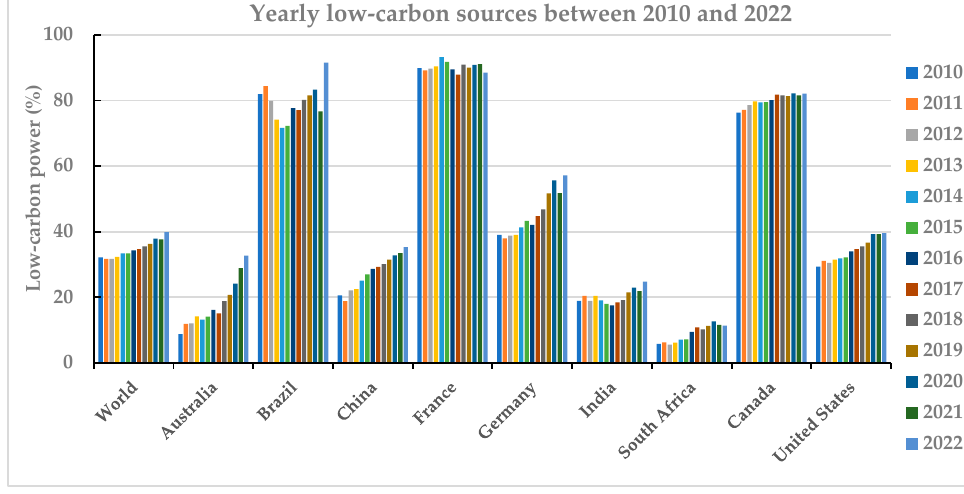
Figure 6. Percentage of electricity generated domestically from low-carbon sources [109].